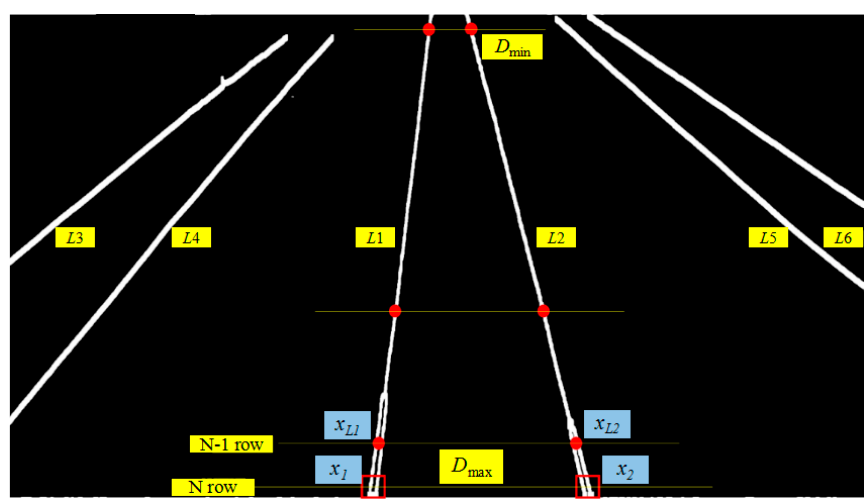
Figure 13. Schematic diagram of track region extraction algorithm based on track line matching. Determine the starting point. As the train is moving along a line, the image usually extends from the bottom up (excluding the lack of image visual field angle in the process of turning—blind area). Next, search for the starting point on the track line binary map from the N row ( N starts at the bottom of the image). All points are considered as possible starting points, and the search area is the lateral width of the whole image. If a point x i ( i = 1, 2, 3…) is found with a pixel value of 255 (white dot) and the pixel next to the left has a value of 0 (black dot), it is the starting point. If no possible starting point is found in the N row, then continue to n-1 row. By analogy, if the starting point cannot be found in the N max row (indicating the maximum fracture line acceptable for the starting position), the search for the starting point in this connected domain will be abandoned and this step will be repeated in the next connected domain.